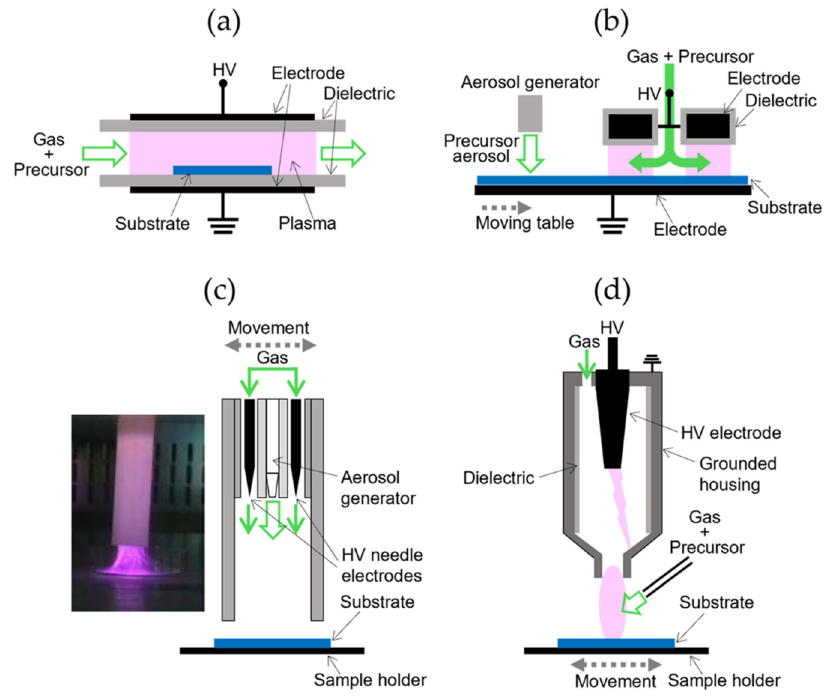
Figure 2. Selected examples of APP systems used for the preparation of nanocomposite coatings. ( a ) Classical symmetric parallel-plate DBD system [60,62,64] used for the direct PECVD or AAPD of NC films. ( b ) Parallel-plate DBD system used in [59,80] for NC film deposition from aerosols of NPs dispersions or precursors solution. ( c ) Corona discharge-based plasma jet (PlasmaStream™) used for remote AAPD processes [57,81,82]. Reproduced with permission from [81]. ( d ) Arc jet commercialized by Plasmatreat used for the remote AAPD [83] or PECVD [84] of NC films.